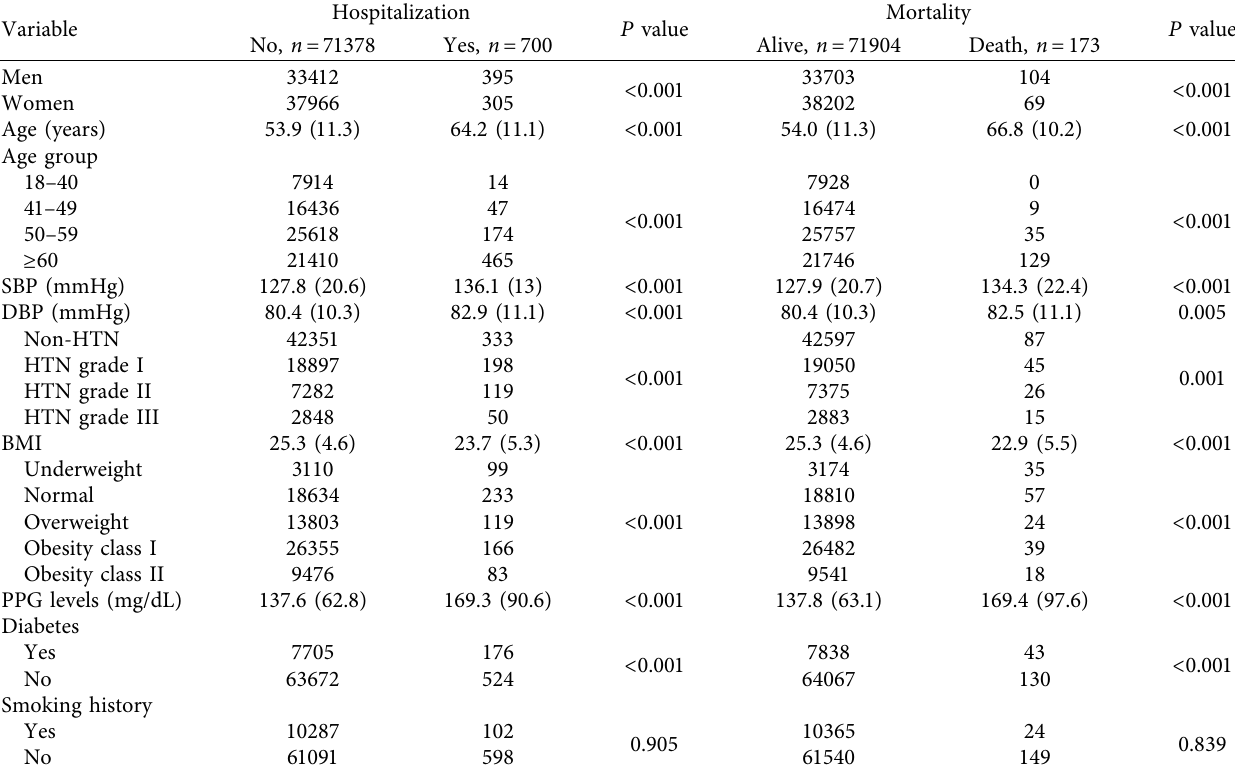
Table 2: Univariate analysis for hospitalization and mortality of Hajj pilgrims from East Java, Indonesia, from 2017 to 2019.